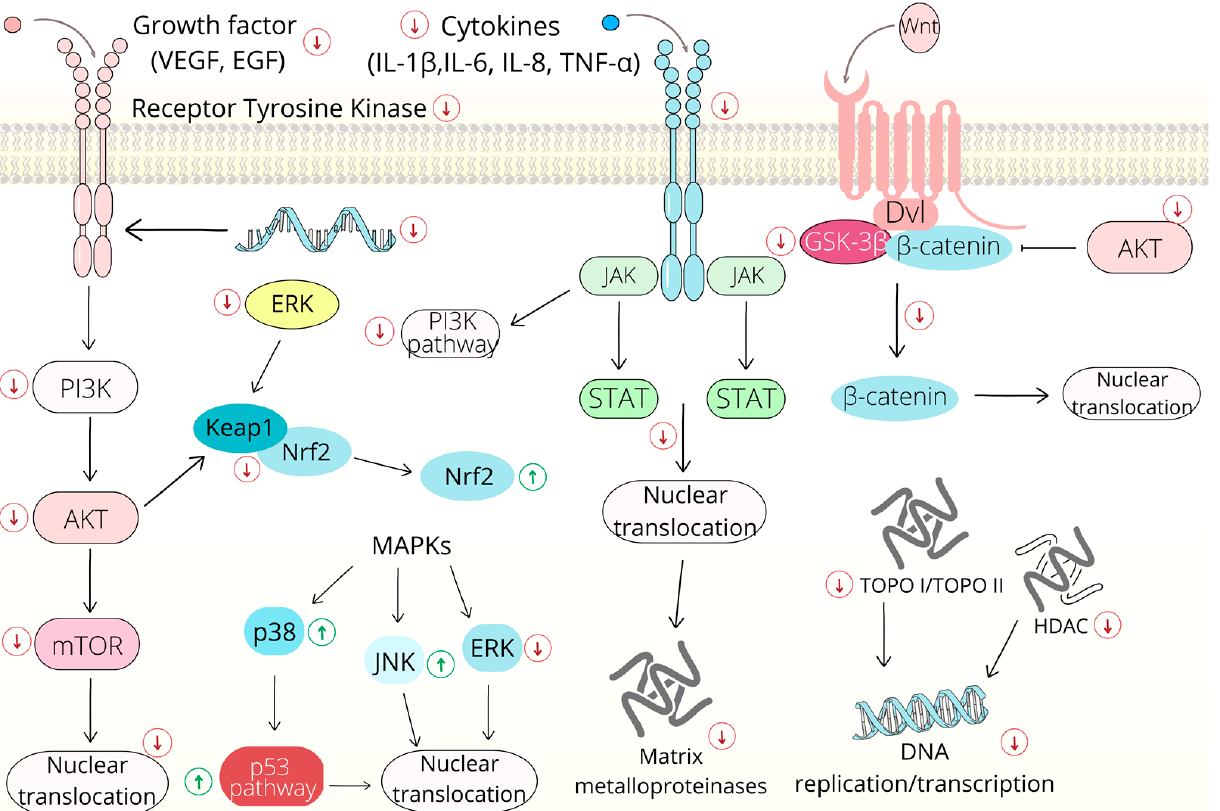
Figure 3. Effect of chalcones on selected signaling pathways. Mechanism of modulation of intracel- lular signaling pathways in gastrointestinal cancer cells. Abbreviations: AKT—protein kinase B, Dvl—disheveled, EGF—epidermal growth factor, ERK—extracellular signal-regulated kinase, GSK-3 β —glycogen synthase kinase-3 beta, HDAC—histone deacetylase, IL—interleukin, JAK—Ja- nus kinase, JNK—c-Jun N-terminal kinases, Keap1—Kelch-like ECH-associated protein 1, mTOR— mammalian target of rapamycin, Nrf2—NF-E2–related factor 2, p38—p38 mitogen-activated pro- tein kinase, p62—sequestosome 1, PI3K—phosphoinositide 3-kinase, ROS—reactive oxygen spe- cies, STAT—signal transducer and activator of transcription, TOPO I/II—topoisomerases I/II, TNF- α —tumor necrosis factor alpha, VEGF—vascular endothelial growth factor. The original figure was